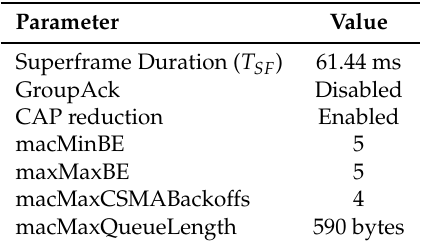
Table 2. Simulation parameters.